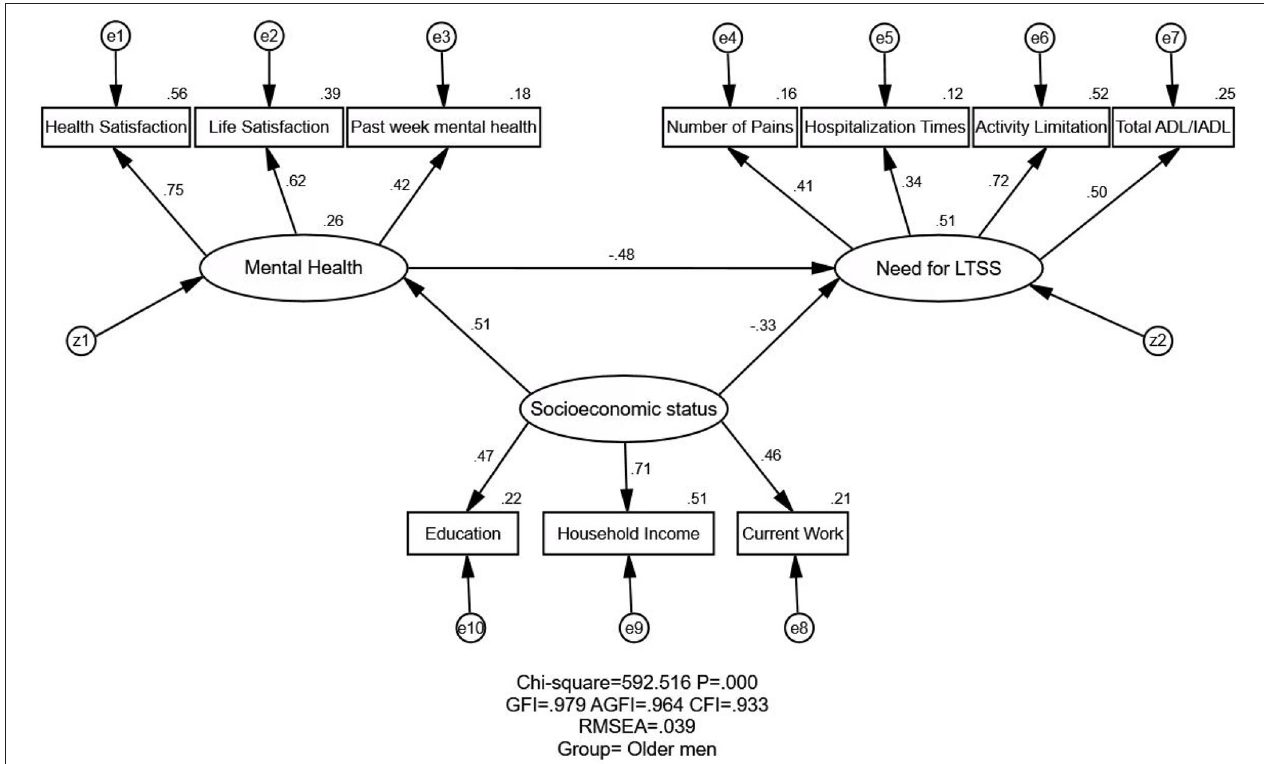
FIGURE 1 | Structural equation modeling analysis of the association between SES, mental health, and the need for LTSS among South Korea’s older men ( n = 2,353). The data were employed to analyze the association between SES, mental health, and the need for LTSS. The arrows indicate the associations and directions between variables. All parameter estimates were statistically significant ( p < 0.001). χ 2 , chi-square value; GFI, goodness of fit index; AGFI, adjusted goodness of fit index; RMSEA, root-mean-square error of approximation; SES, socioeconomic status; Need for LTSS, need for long-term services and support; CMIN, the chi-square value as noted in